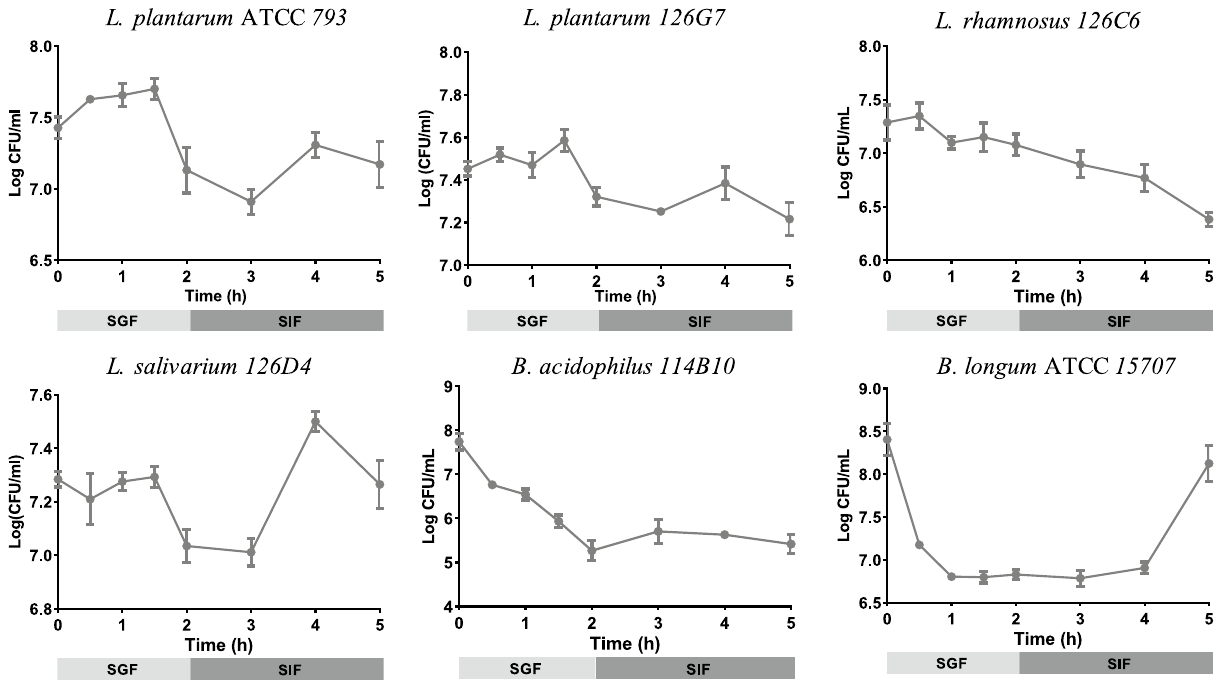
Figure 4. Testing probiotic integrity in simulated conditions. Gut bacteria isolated from healthy human fecal matter were verified for their probiotic activity by testing acid and bile tolerance in 2 h of simulated gastric fluid (SGF) and subsequently, 3 h in simulated intestinal fluid (SIF), respectively. Enumeration of Lactobacillus species was conducted with serial plating on Man-Rogosa-Sharpe (MRS) media under aerobic conditions while Bifidobacteria species were quantified on MRS media supplemented with cysteine in anaerobic conditions. Each time-point represents n = 3 independent trials +/− SEM. Variability over time was conducted with a one-way ANOVA using Kruskal Wallis analysis where *p < 0.05.